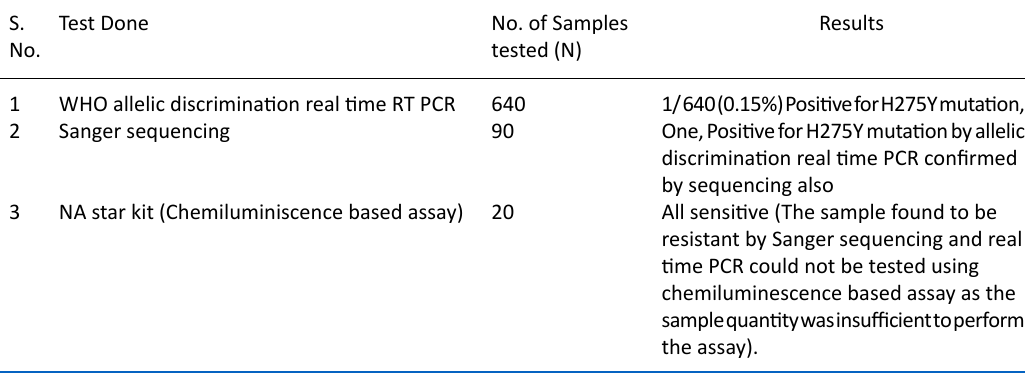
Table 3. Results of tests performed for drug resistance in Influenza A (H1N1) pdm 09 samples